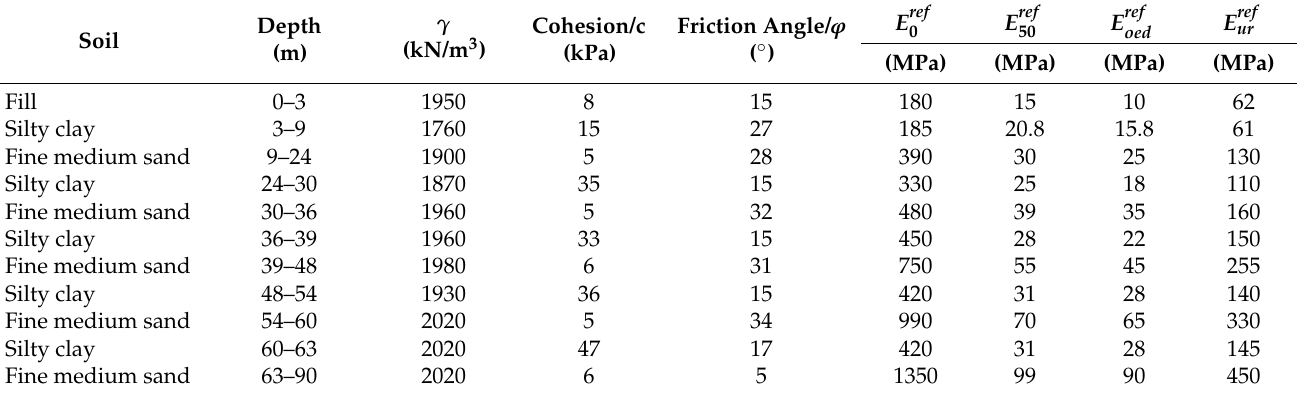
Table 1. Physical and mechanical parameters of the